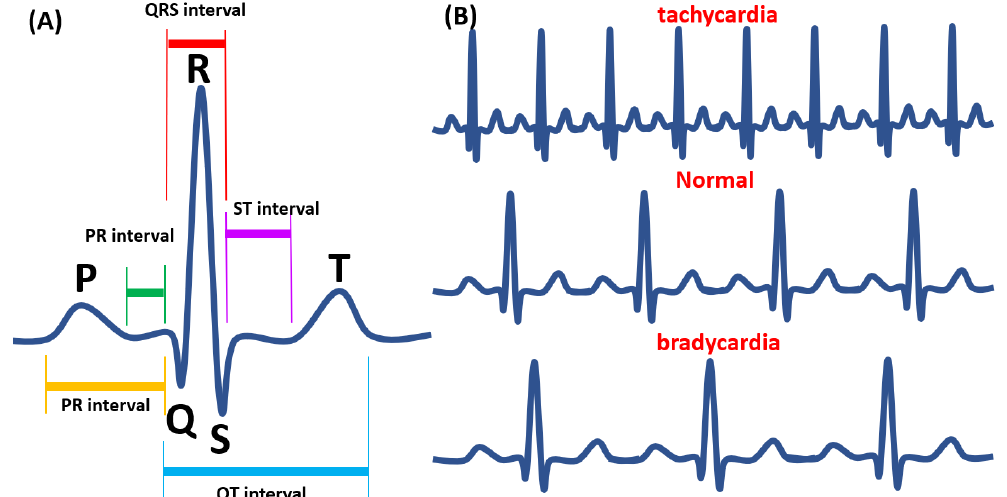
Figure 2. The Electrocardiography (ECG) waveform in adult zebrafish. ( A ) The waveform analysis of ECG. ( B ) Tachycardia (upper panel), normal (middle panel), and bradycardia (lower panel) heart pattern was shown according to a previous publication [73].